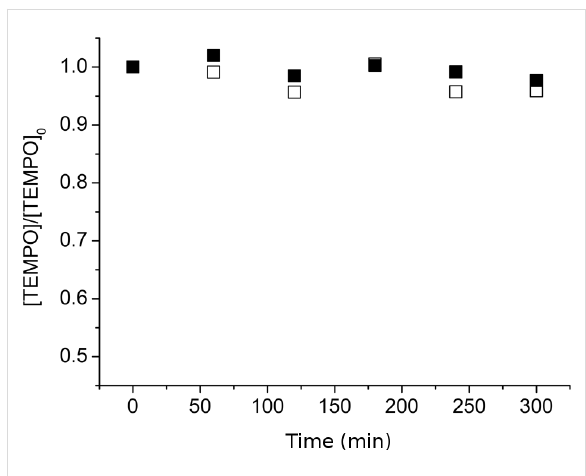
Figure 7: Degradation of the TEMPO nitroxide versus time in DMA in the presence of 0% lithium salt (empty squares) and 4.5 wt % LiCl (filled squares) as measured by ESR in t -BuPh at 25 °C (samples heated at 120 °C in DMA, removed after 1 to 5 hours and diluted in t